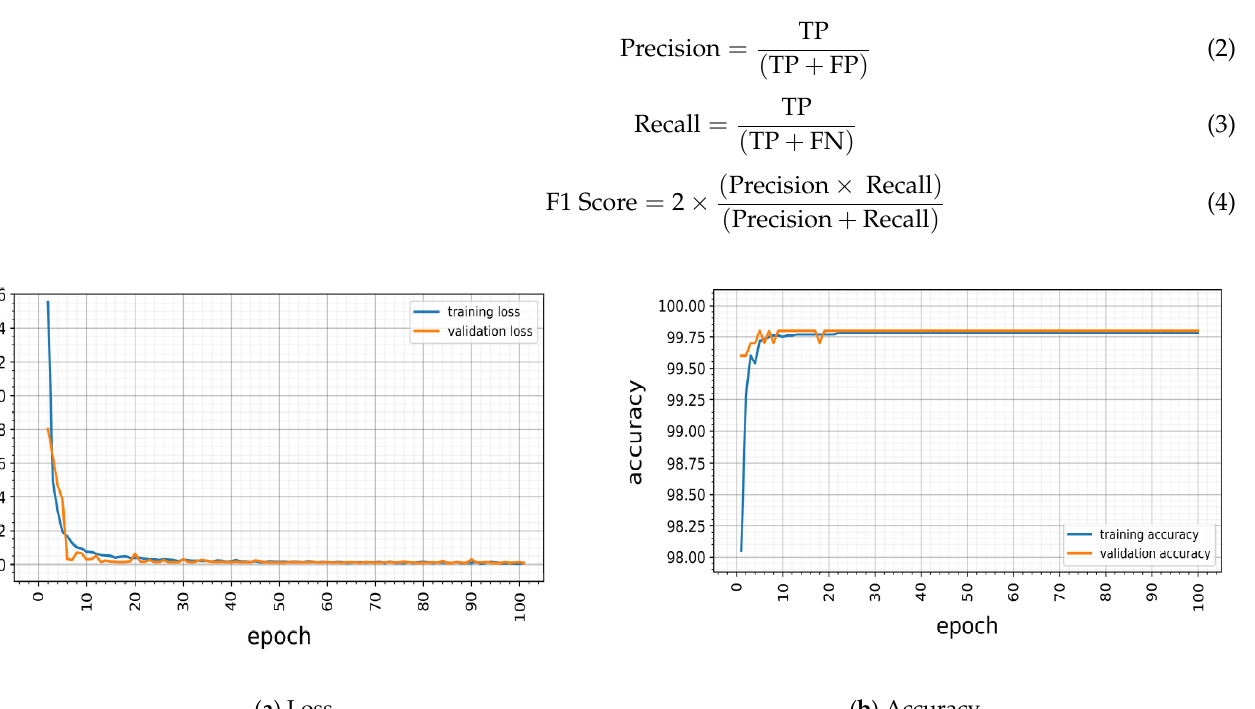
Figure 2. Multiclass CNNGRU model loss and accuracy in training and validation.